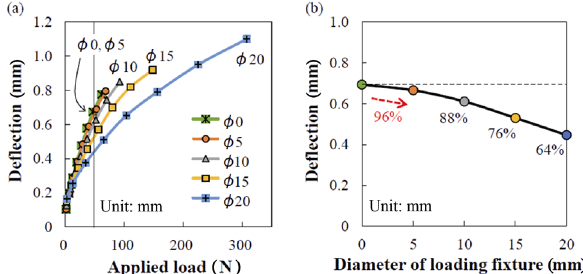
Fig. 7 Deflection of PZT ceramic plate as a function of (a) applied load and (b) loading fixture diameter for 50 N applied